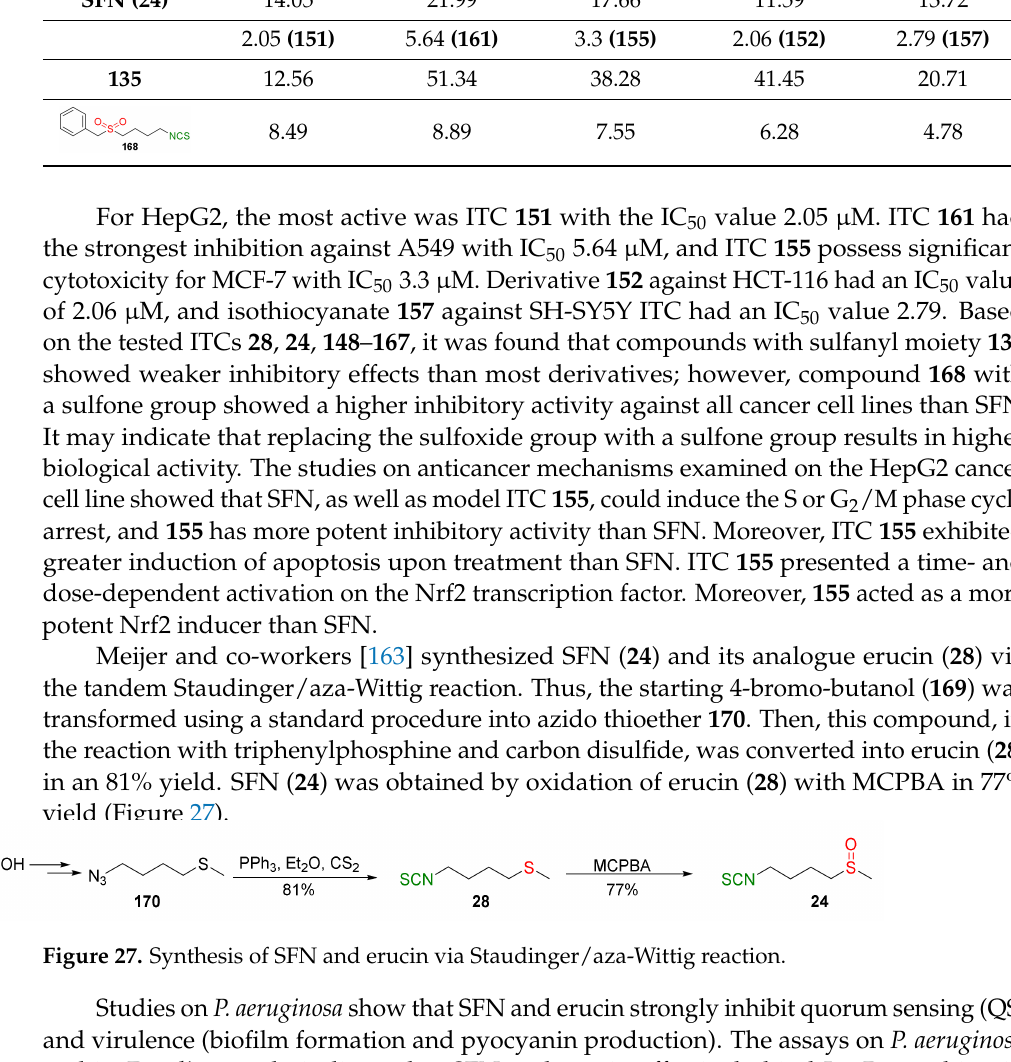
Table 5. The cytotoxicity of SFN and its derivatives. Compound